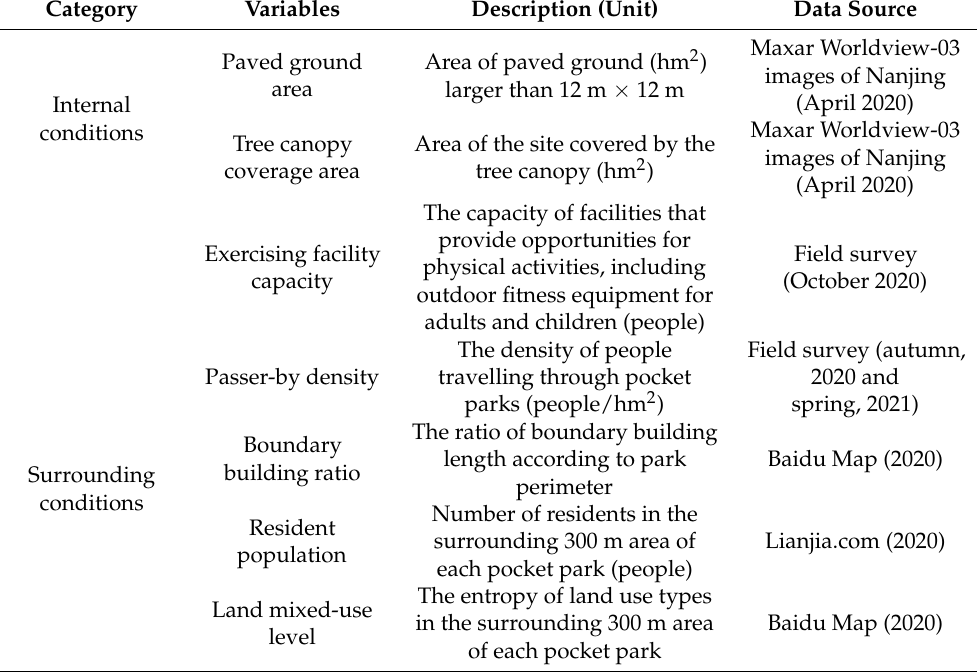
Table 2. Independent variables’ descriptions and data sources.